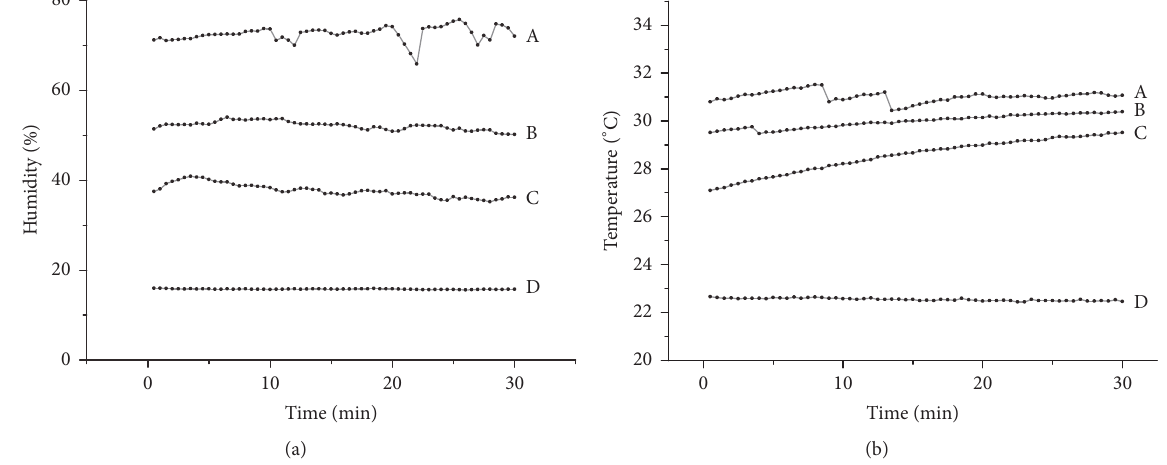
Figure 4: Measurements of periocular humidity and temperature over time. The average of periocular humidity and temperature over time in 10 volunteers. (a) Pressurized wearing of uniformed moisture chamber spectacles, (b) natural wearing of personalized moisture chamber spectacles, (c) natural wearing of uniformed moisture chamber spectacles, and (d) ambient